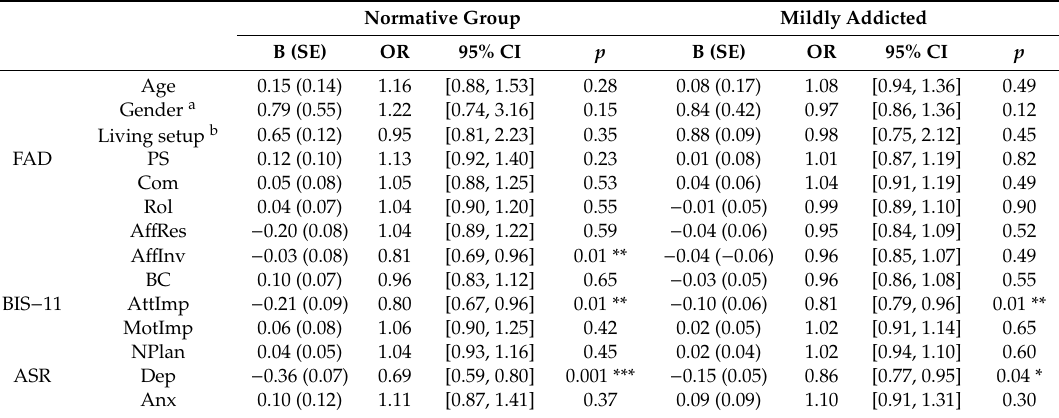
Table 3. Multinomial logistic regression comparing normative users and mildly addicted users with moderately addicted